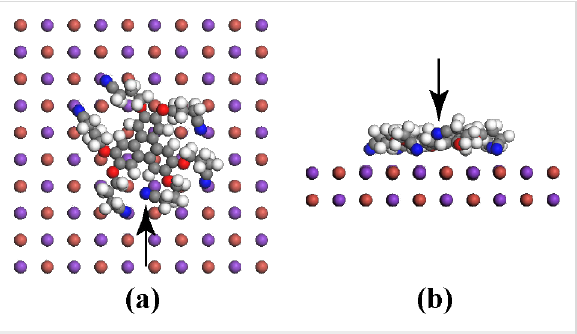
Figure 9: Lowest-energy adsorbed conformation of HCPTP adsorbed on KBr(001). (a) Top and (b) side view. K + ions are violet, N atoms are blue. The arrow in (b) points to the CN group that is not bound to a K +